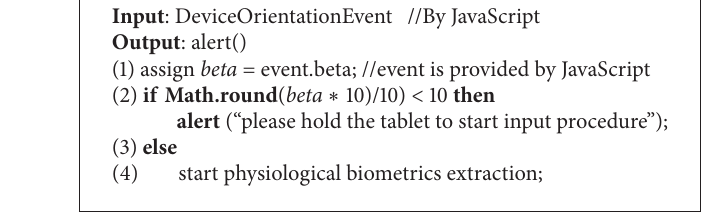
Algorithm 1: Check orientation algorithm.